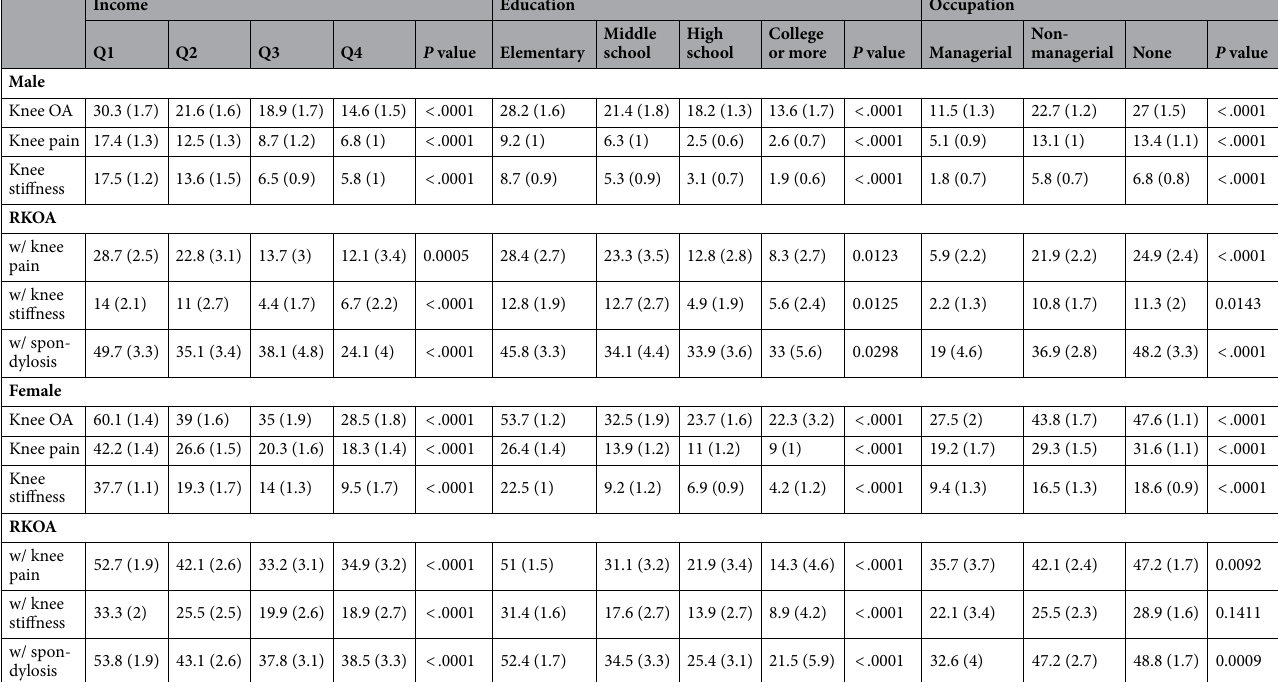
Table 2. Prevalence of knee OA and knee symptoms by components of socioeconomic status. Numbers are n% (SE). OA, osteoarthritis; RKOA, radiographic knee osteoarthritis.